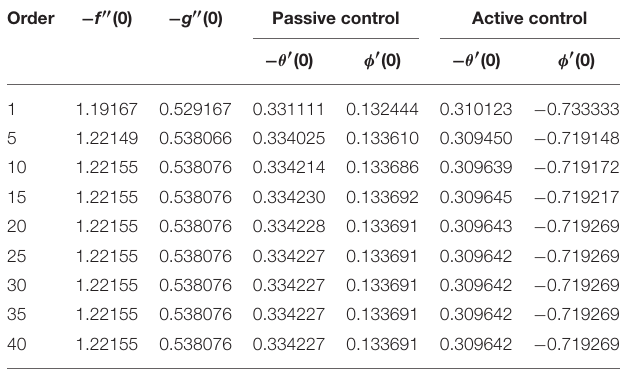
TABLE 1 | Order of approximation. TABLE 2 | Comparison of